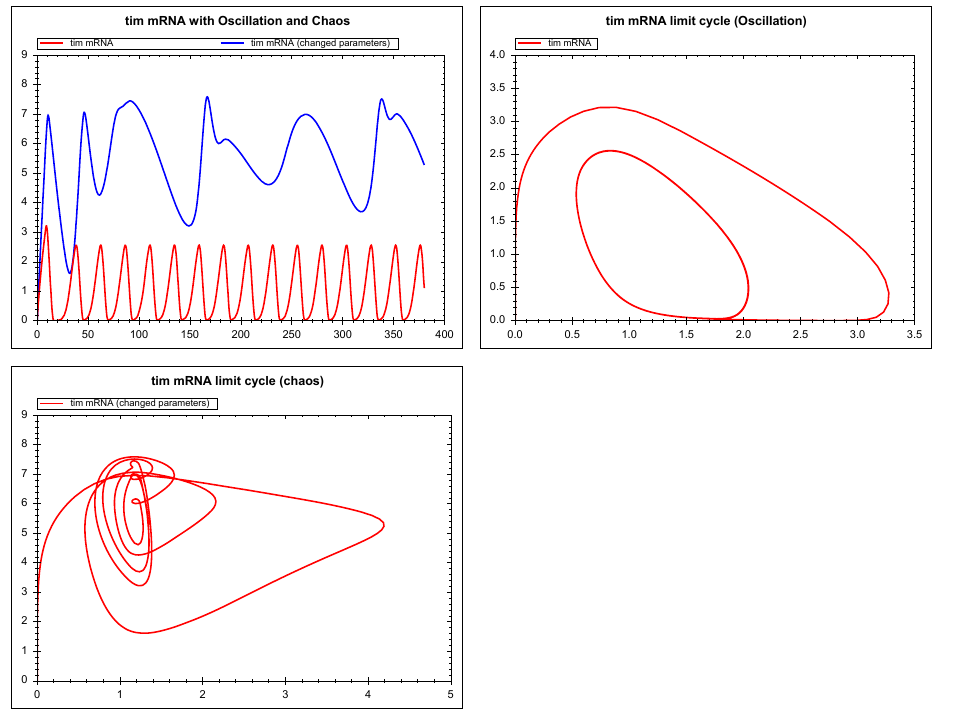
Figure C.1: The simulation result gained from the simulation description given in Listing